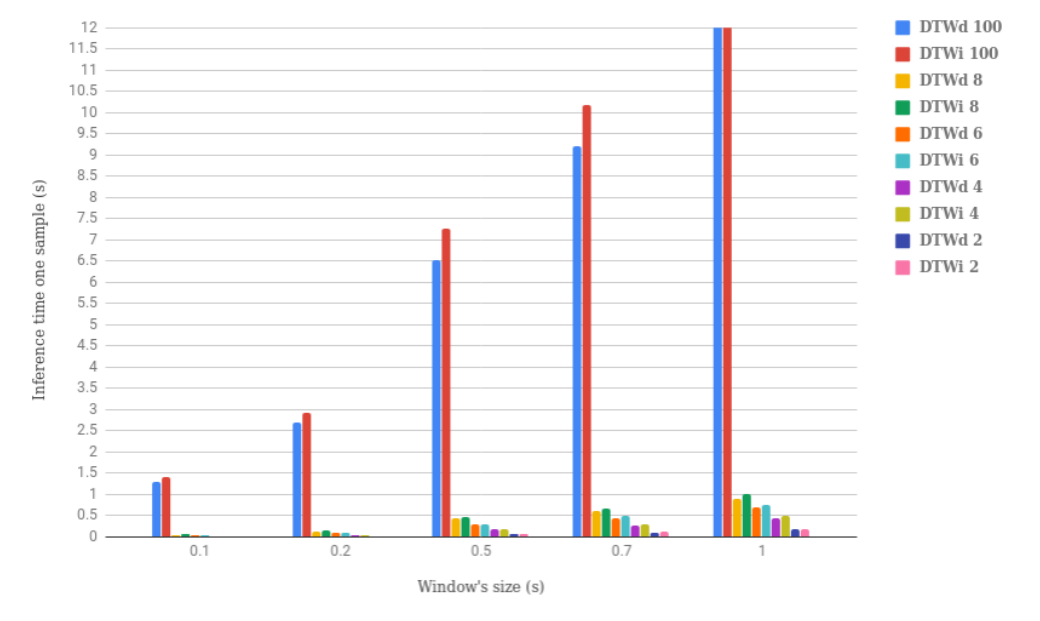
Figure 8. Graphical representation of the values of the inference time per sample for the different types of raw data based classification (dependent and independent DTW), sampling window’s size (0.1, 0.2, 0.5, 0.7, and 1.0 s) and percentage of sub-sampling (where 100 means non-sub-sampling). The longer the window of data we consider, the longer the inference time. The total time to recognize the operator’s intent is the addition of the window’s size (horizontal axis) plus the inference time per sample (vertical